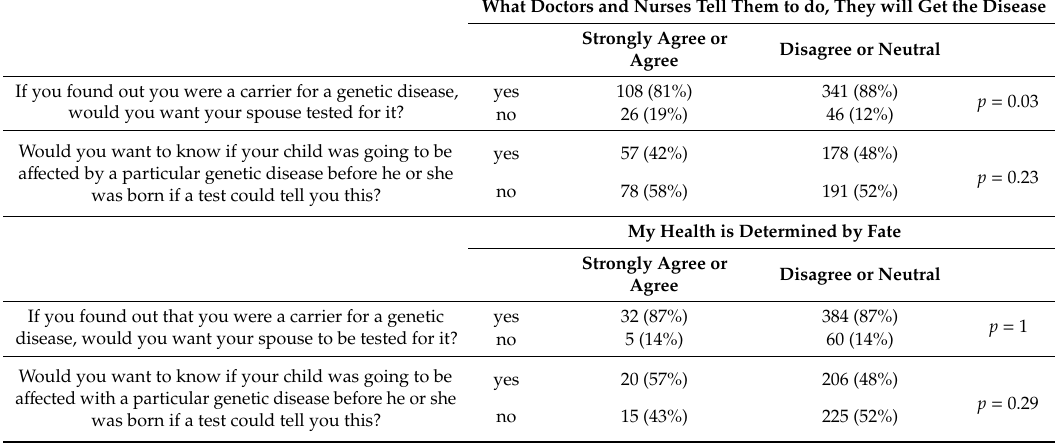
Table 7. The relationship between attitudes on genetic testing and fatalism in 5 Pennsylvania Plain